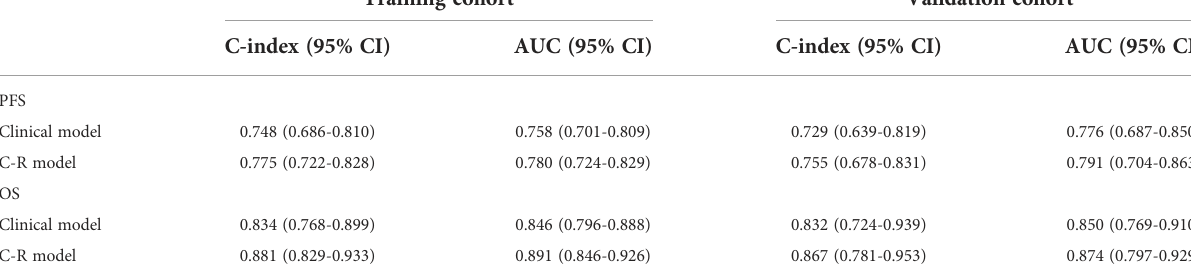
TABLE 4 The Harrell ’ s C-index and AUC results in the training and validation